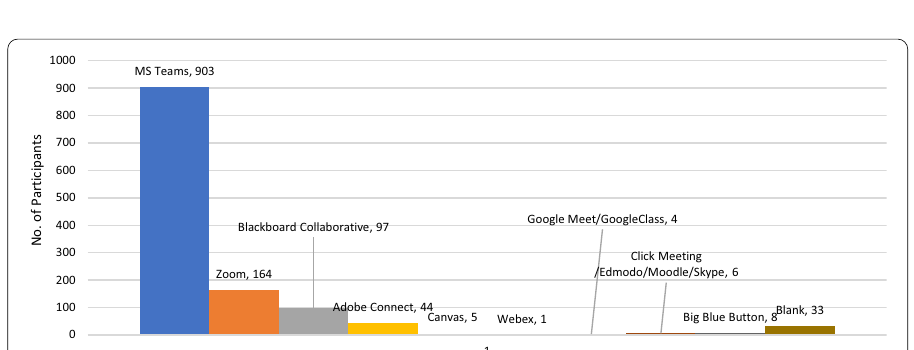
Fig. 4 E-learning platforms adopted by the U.A.E. based higher educational